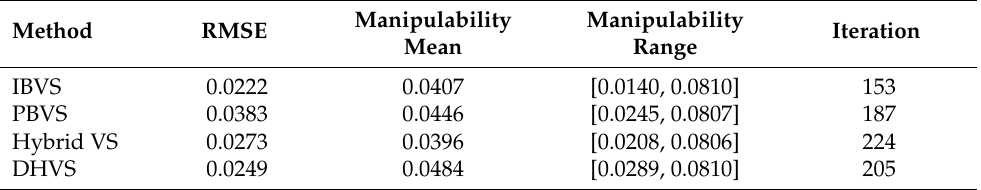
Table 3. Comparison of manipulability in different VS methods.